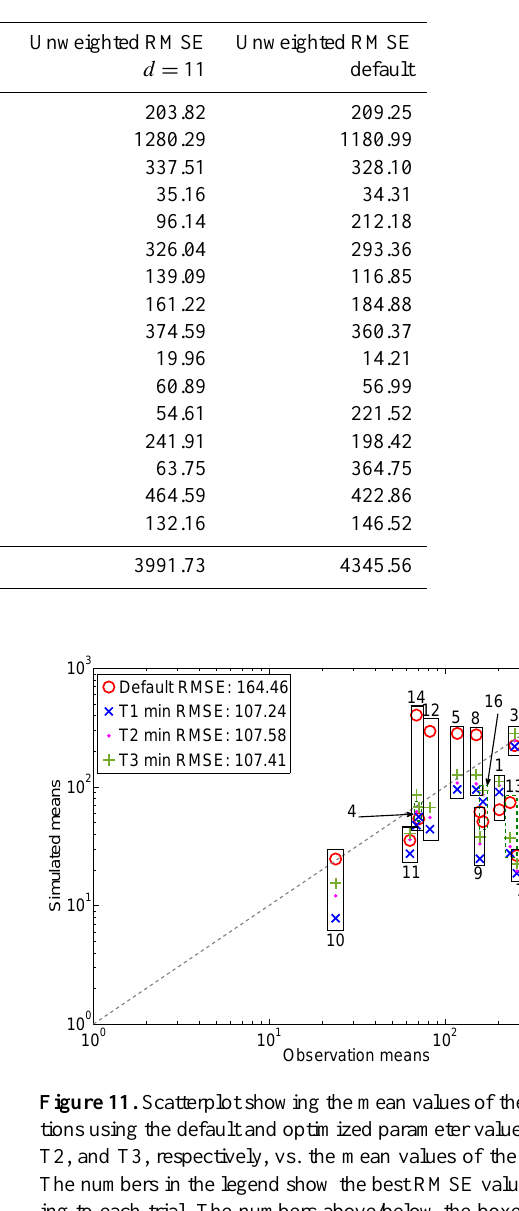
Table 8. Unweighted RMSE values for each site using the best parameters found during optimization trial T1 of the d = 11 real data case and trial T2 of the d = 5 real data case and with default parameter values.